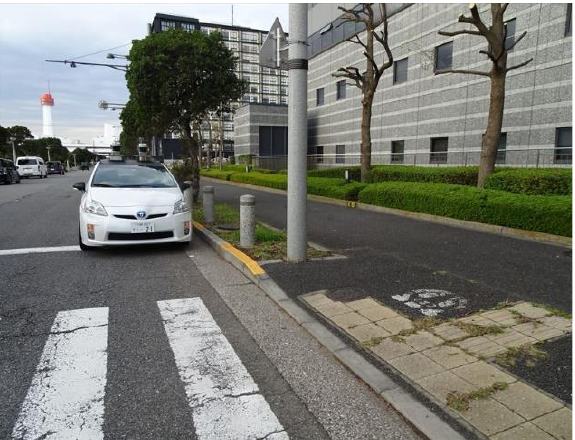
Figure 1. Study area. Participants communicated with vehicle and began crossing from right side of image.